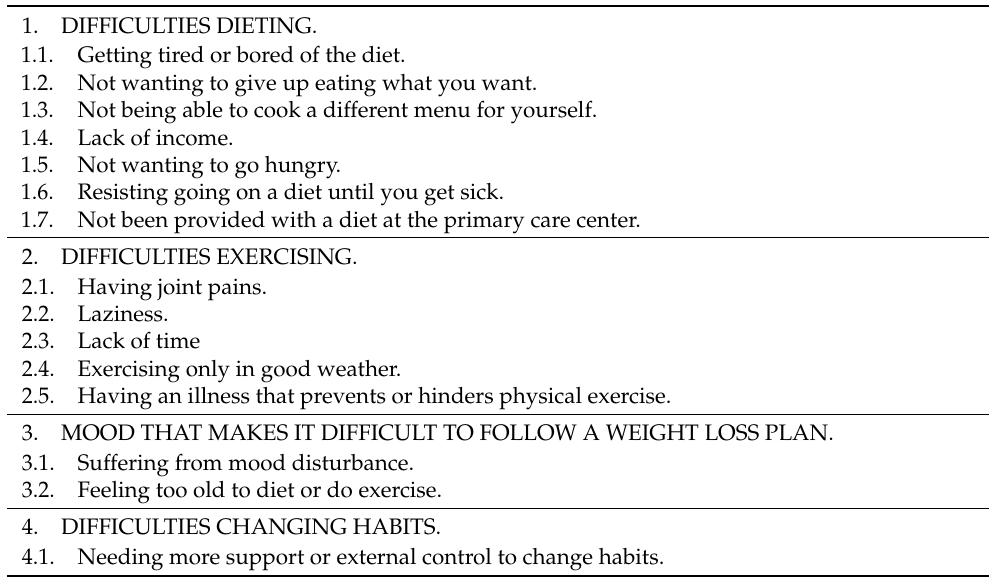
Table 3. Limiting factors for weight loss mentioned by the patients. Categories and